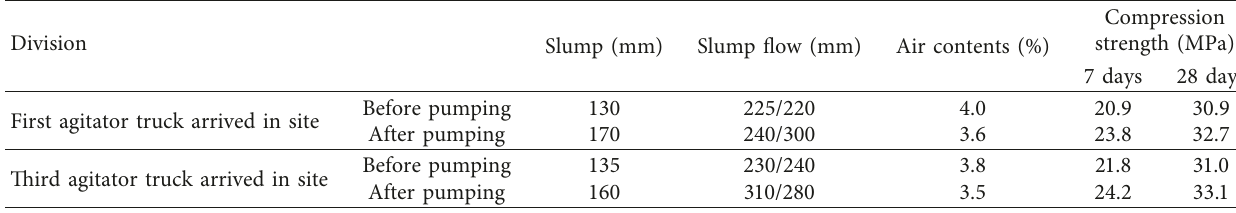
Table 7: Experiment result of